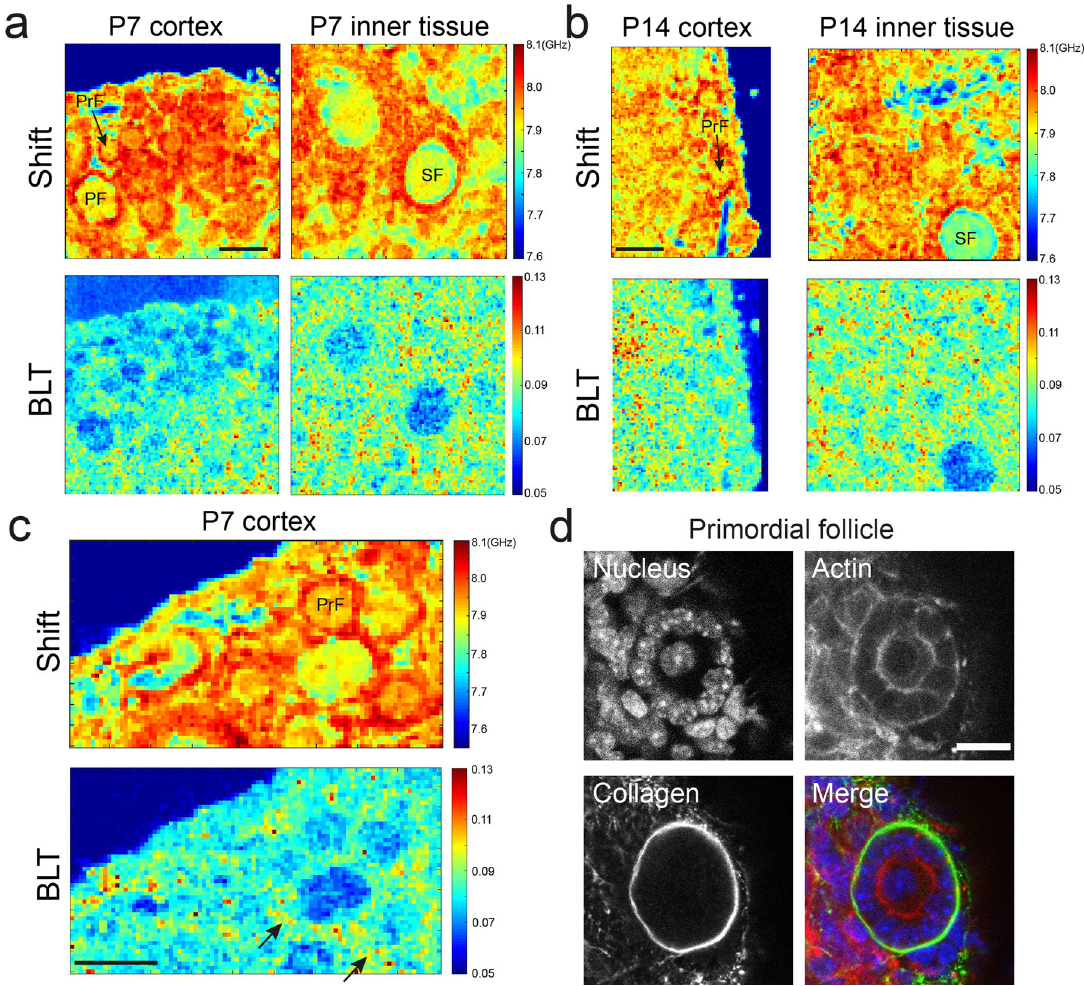
Fig. 2 Ovary tissue is characterized by regional differences in mechanical properties. a Maps of Brillouin shift and the corresponding BLT for a P7 ovarian cortex and the inner tissue. Both images were obtained from the same ovary. Primordial follicles (PrF) and primary follicles (PF) reside primarily in the cortex while the secondary follicles (SF) tend to be found in the inner part of the ovary, which shows a higher interstitial BLT. b Maps of Brillouin shift and BLT for a P14 ovarian cortex and the inner tissue. Similar to P7 ovaries, higher PLT is associated with the inner tissue of the ovaries, compared to the cortex. c Zoom in view of P7 ovarian cortex showing higher BLT of cells (black arrows) surrounding the oocyte, which may be associated with the presence of collagen surrounding the primordial follicle, as shown in d . Scale bar = 40 μ m in a , b , and c , and 15 μ m in d